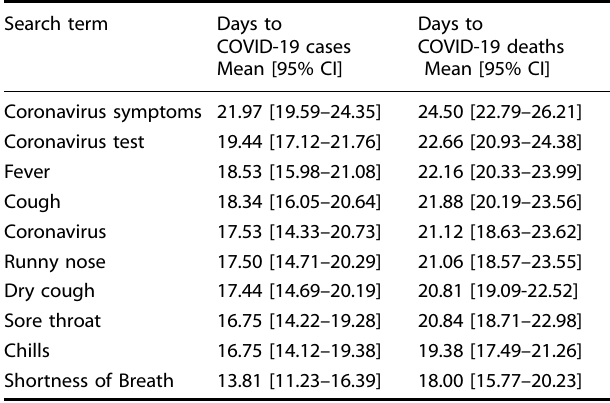
Table 1. Mean lags between search volumes for speci fi c search terms and reported COVID-19 cases and deaths across 32